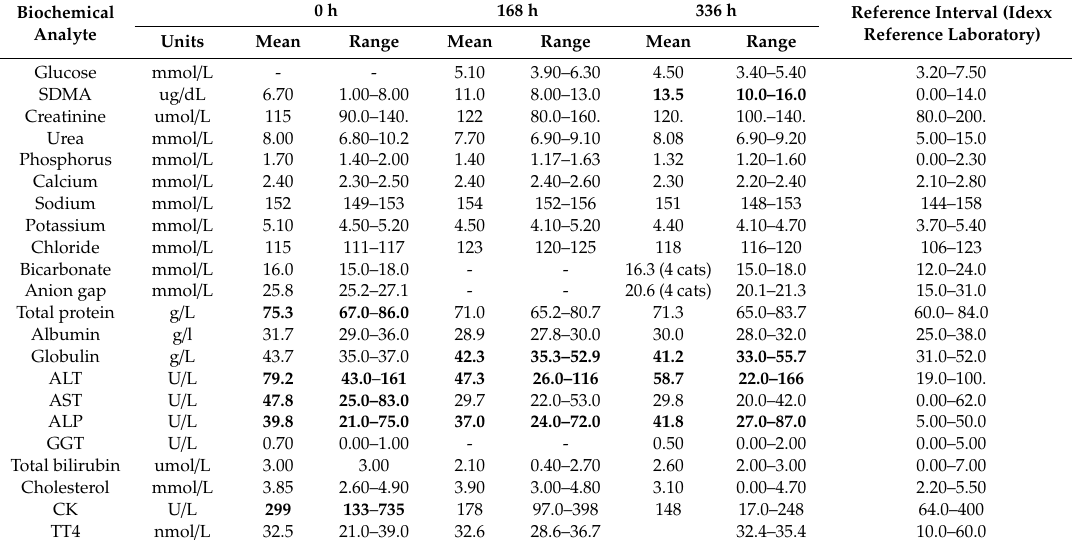
Table 3. Biochemistry results (mean and range) at 0, 168 and 336 h. Numbers outside reference intervals are emboldened. Not all biochemical analytes were provided due to the availability of di ff erent biochemical analytes at di ff erent laboratories, hence the blank cells.